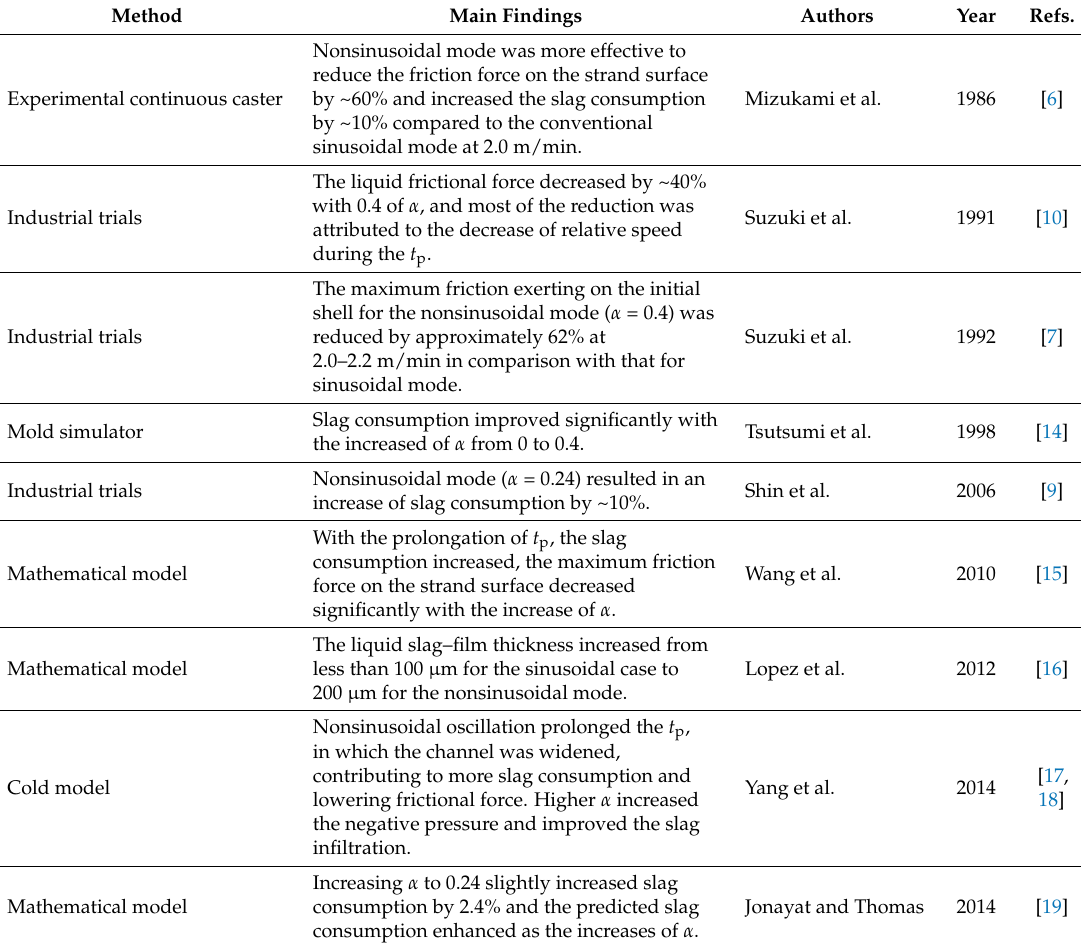
Table 1. Studies of the effect of nonsinusoidal oscillation mode on slag